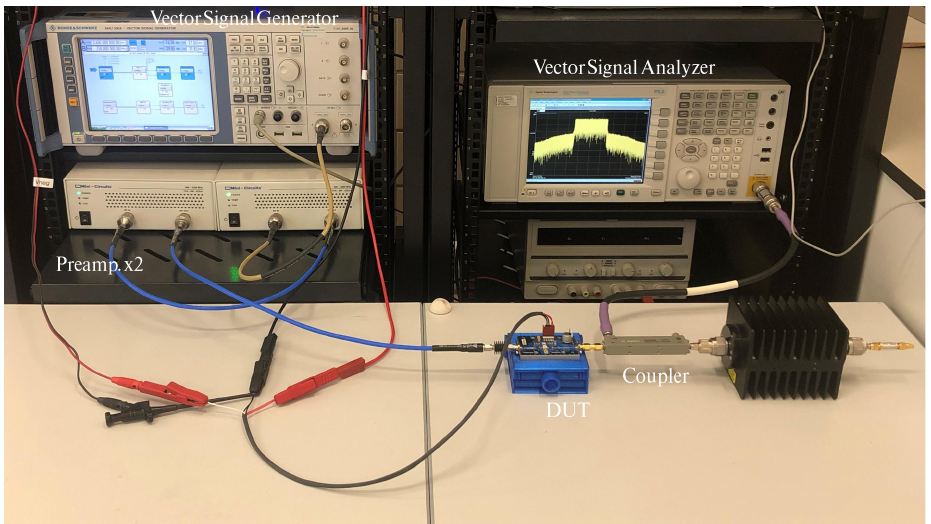
Figure 5. Photograph of the experimental